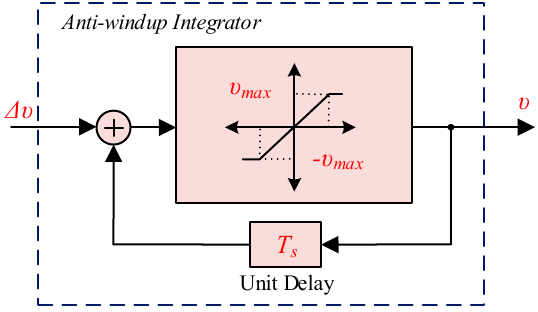
Figure 16. Thrust force of the robotic fish for free-swimming motion during 80 s.